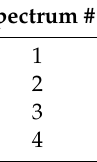
Table 2. Elemental analysis of selected areas in Figure 8c, derived from the spectra in Figure 8d.